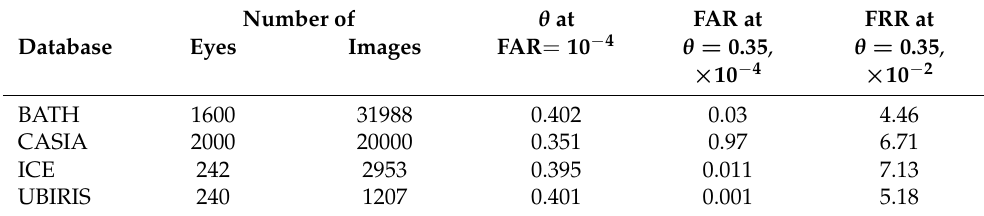
Table 5. Database characteristics and